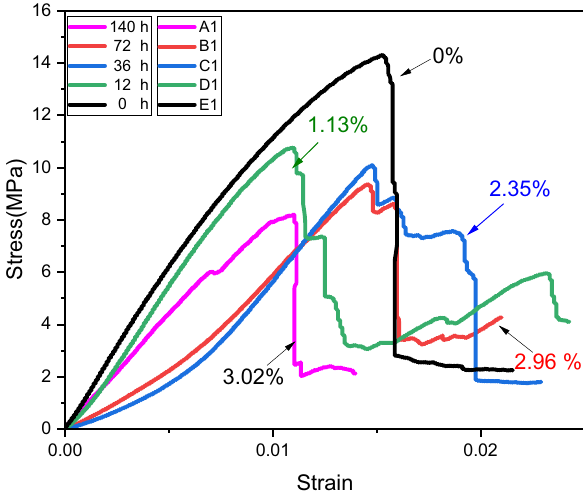
Figure 5. The stress strain curves of coal sample with different water content.